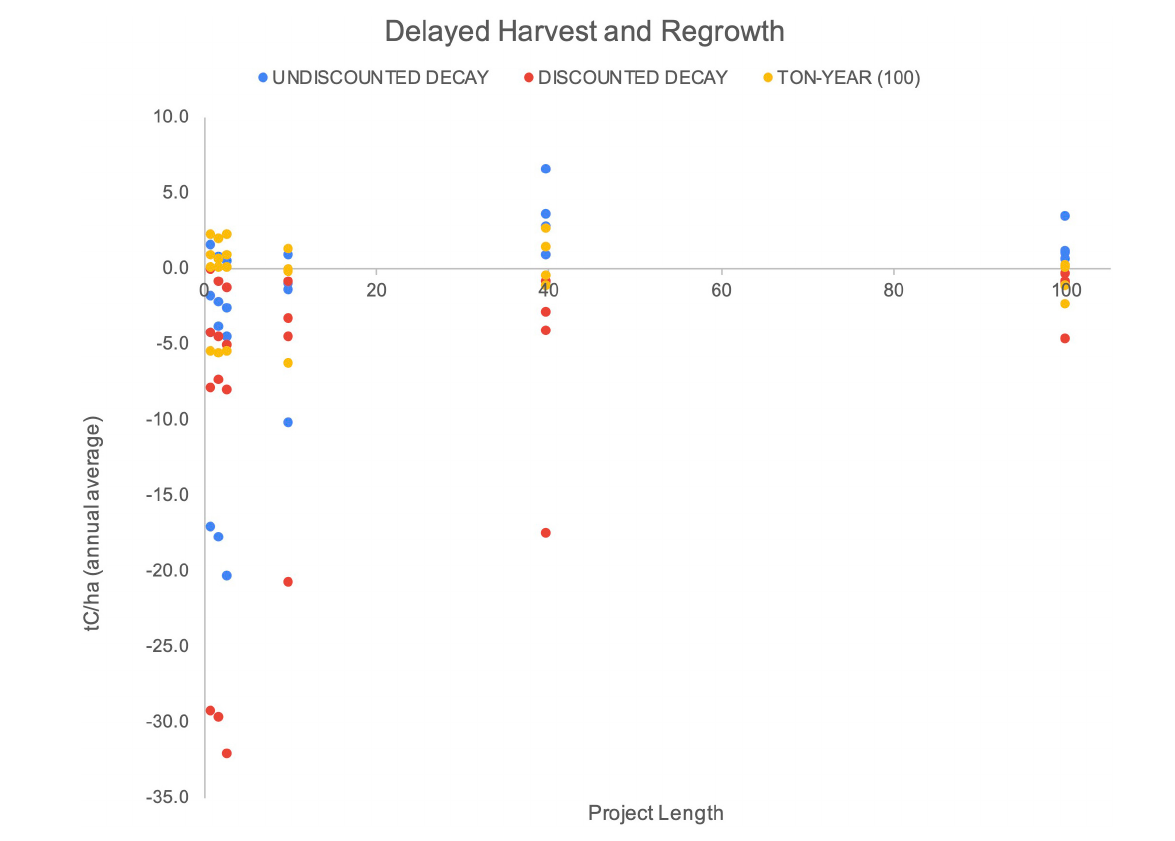
FIGURE4 Average annual net flux (tC/ha) by project length for deferred harvest and regrowth projects. Accounting approach and forest type for extreme values are indicated. Ton-year results reflect a 100-year time horizon. Negative values represent net sequestration relative to a baseline, immediate-harvest